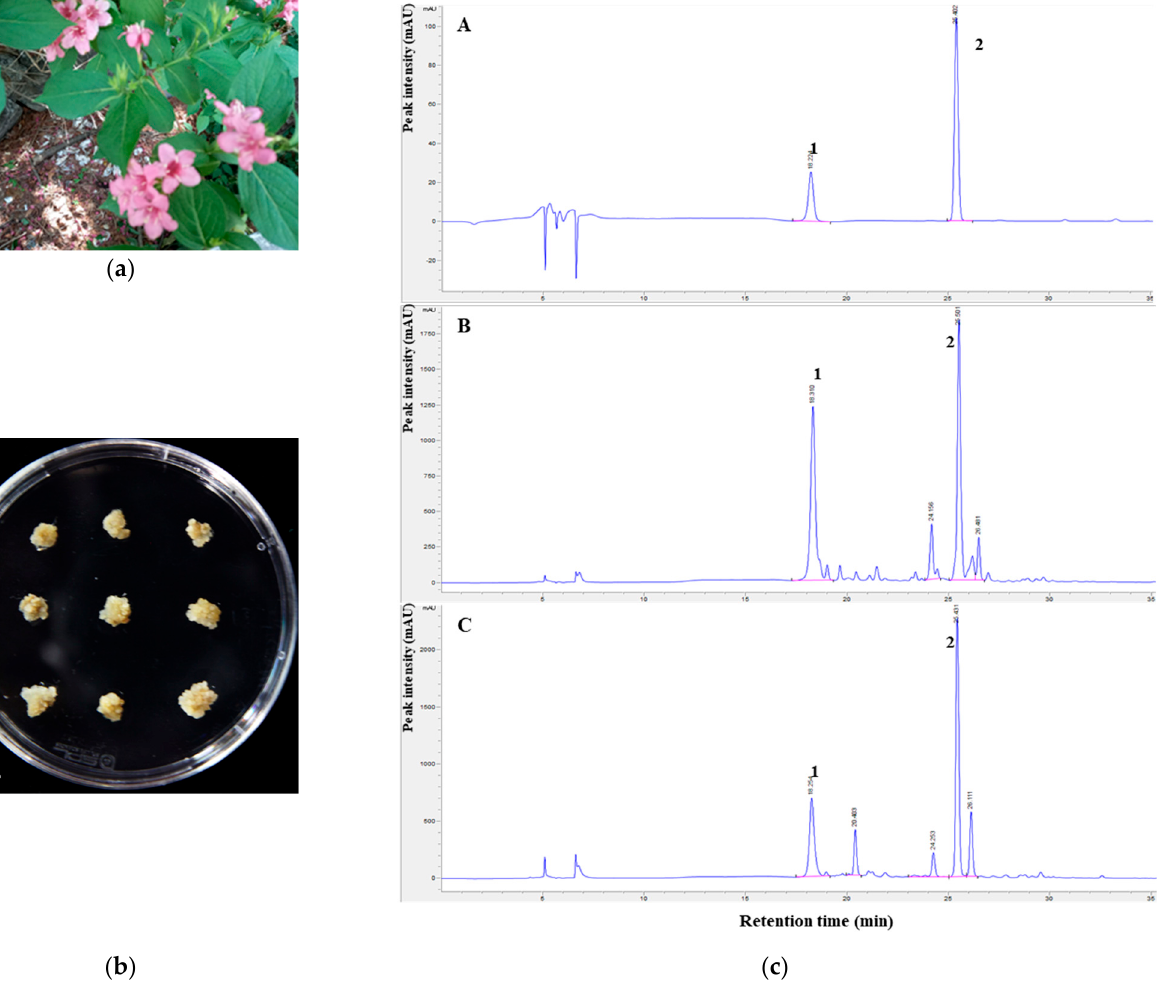
Figure 1. Establishment of an in vitro proliferation system from stem explants of W. subsessilis : ( a ) Field grown plant of W. subsessilis ; ( b ) In vitro grown calluses of W. subsessilis . Scale bar, 1 cm; ( c ) HPLC chromatograms of scopolin (1) and scopoletin (2) in extracts of W. subsessilis . A methanol extract of W. subsessilis callus was analyzed compared to standard peaks with octadecyl-silica analytical column ( A ), standard; ( B ), callus of W. subsessilis ; ( C ), leaves of W. subsessilis